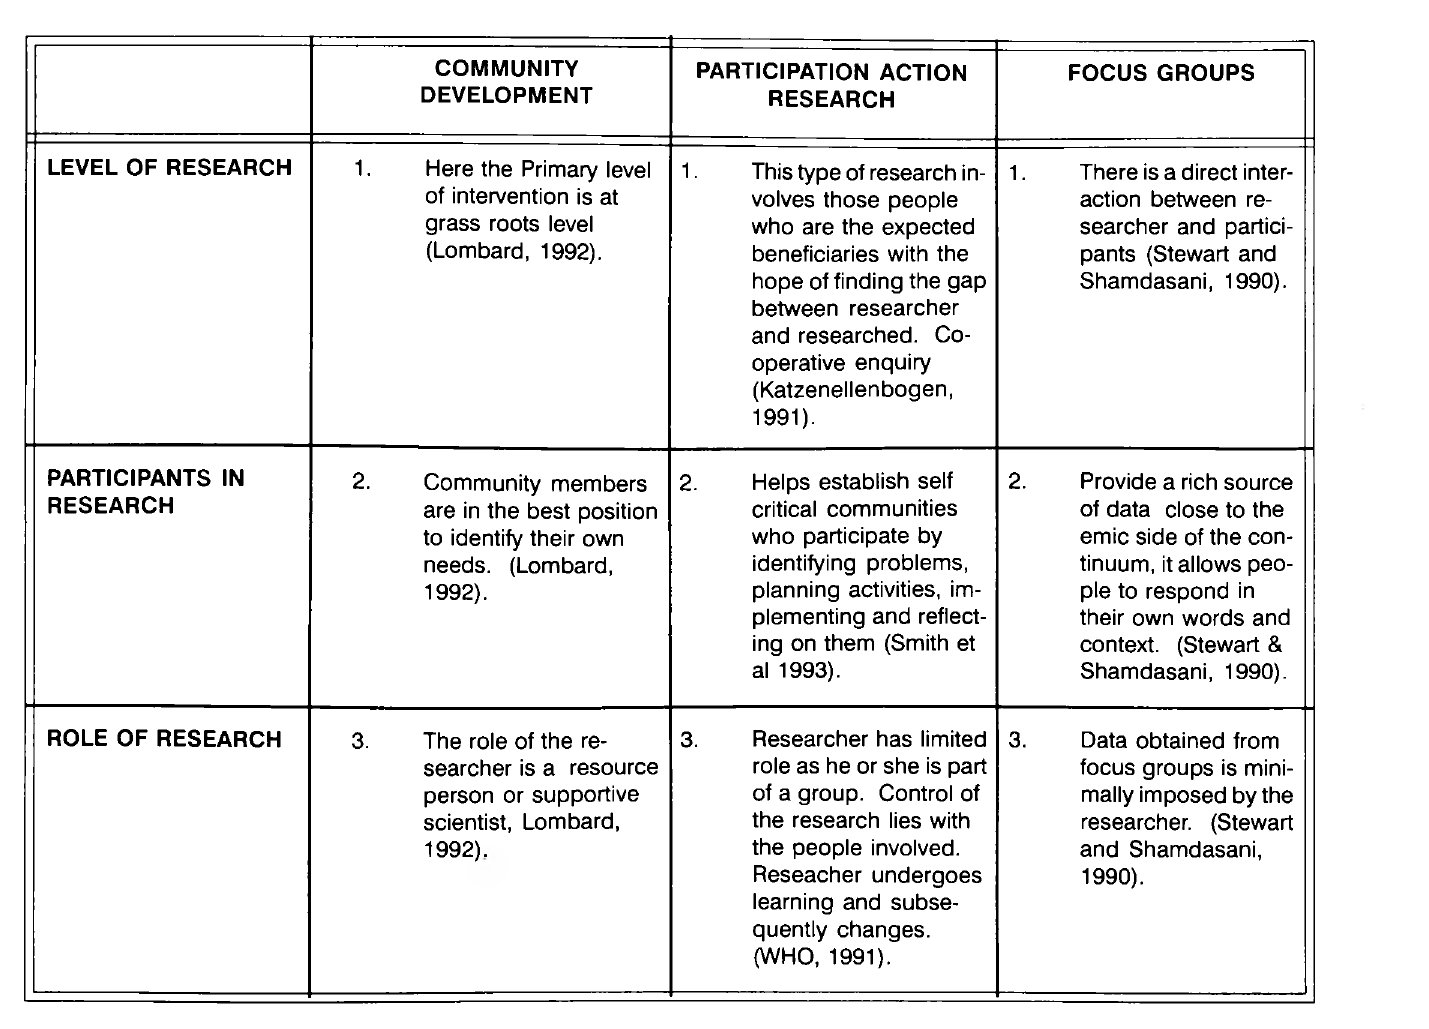
Table 1 : An ilustration of the correlation between model and research